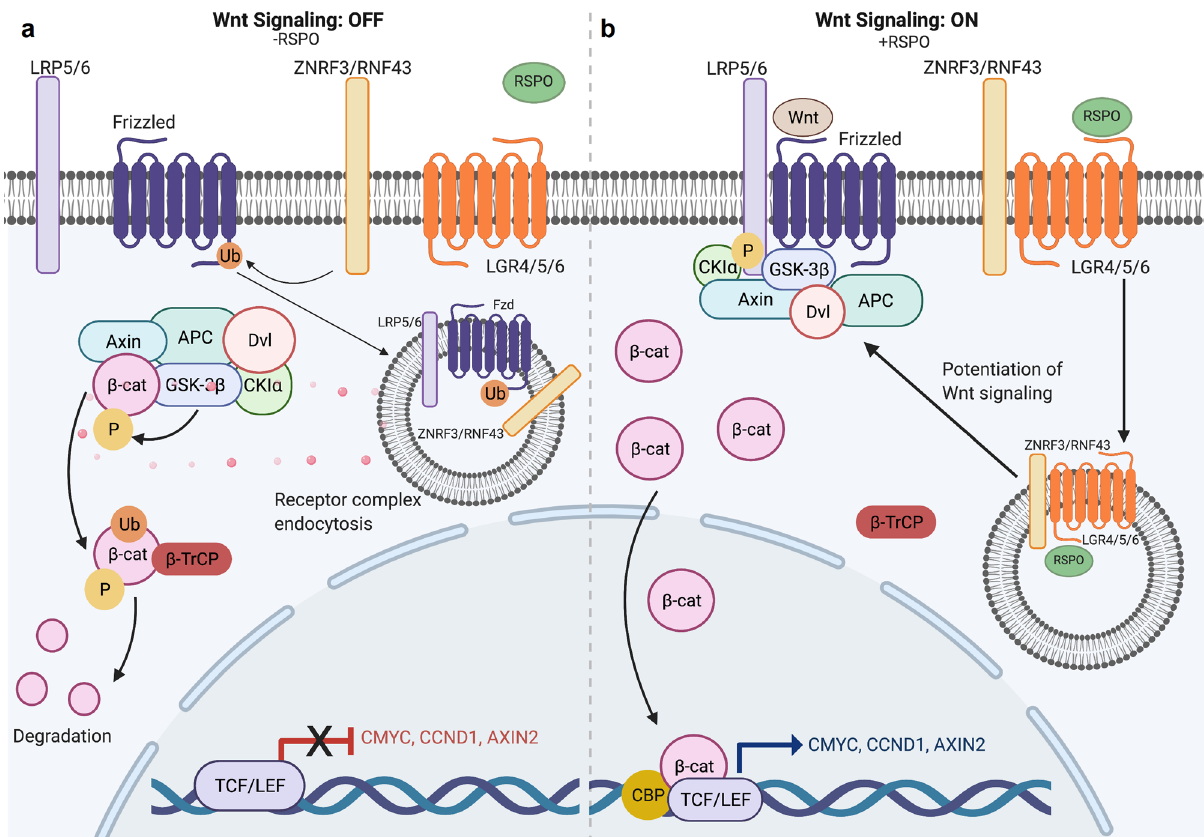
Fig. 1 Overview of canonical Wnt signaling. a In the absence of RSPO binding to LGR4/5/6, ubiquitin ligase ZNRF43/RNF43 ubiquitinates the Frizzled receptor which leads to receptor complex endocytosis, β -catenin degradation and subsequent inhibition of Wnt-driven transcriptional activity 5 . b The binding of RSPO to LGR4/5/6 potentiates Wnt signaling by removing ZNR43/RNF43 ubiquitin ligase from the cell membrane, which would otherwise mark Frizzled receptor for ubiquitination. Frizzled receptors are then able to interact with both Wnt ligand and LRP5/6 co-receptor to drive Wnt signaling cascade. β -catenin then escapes cytoplasmic proteasomal degradation, resulting in its nuclear translocation, interactions with transcription factors. TCF/ LEF, and subsequent transactivation of Wnt target genes like c-MYC, CyclinD1, and Axin2 5